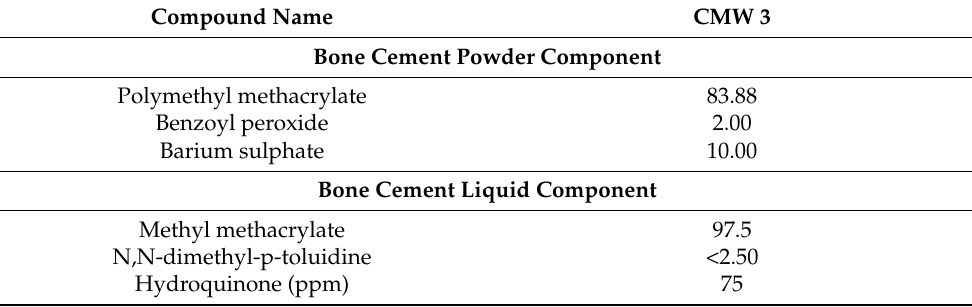
Table 2. Chemical composition of CMW 1 and CMW 3 bone cements.